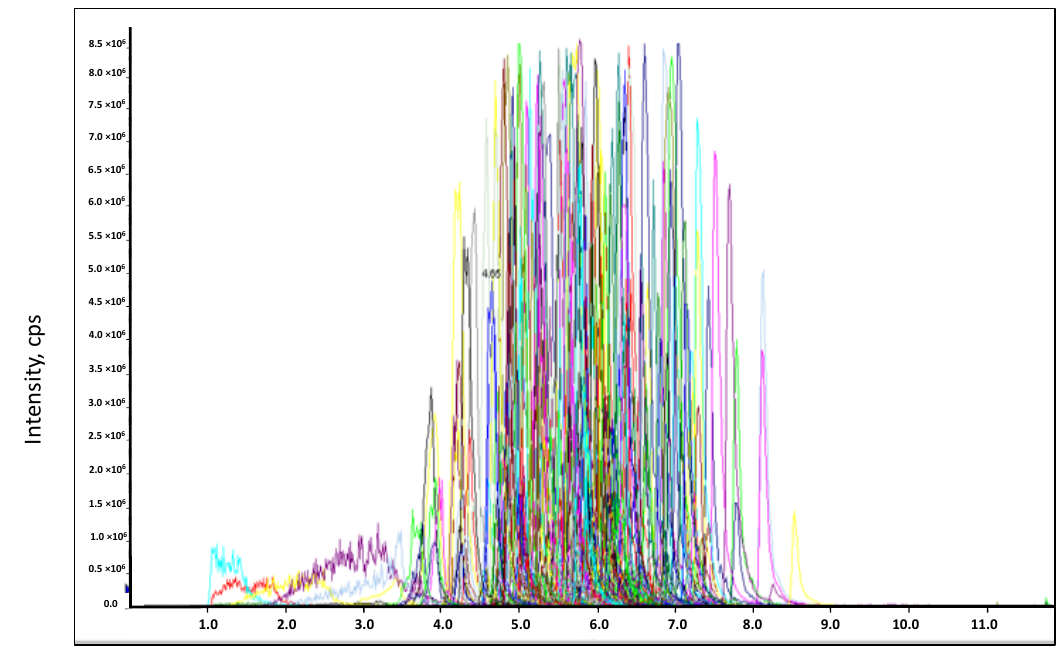
Figure 1. Extracted Ion Chromatograms (EIC) of the quantitative transition for the 179 pesticides analyzed in a rapeseed extract spiked at 10 µg/kg (each chromatogram was represented with different color).